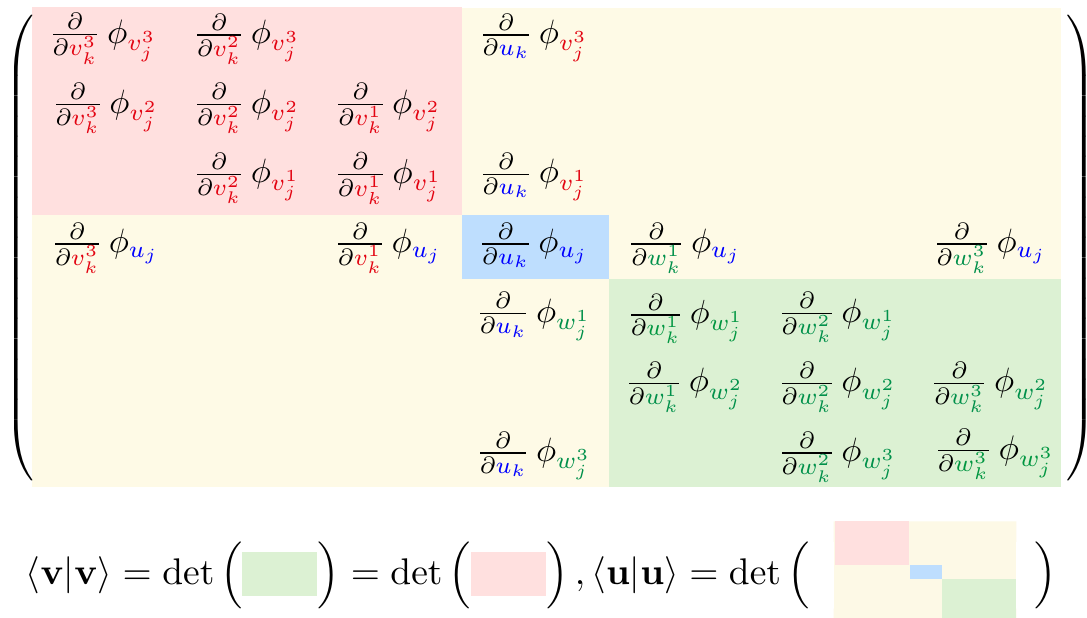
Figure 6. Definitions of the Gaudin norms Bethe equation, e iφ u,v,w = 1. is a determinant of the upper (or equivalently lower) diagonal matrix shown in red (green). The missing matrix elements are vanishing, as a result of the structure of the psu (2 , 2 there is no interaction between auxiliary roots w and v lying on different wings).